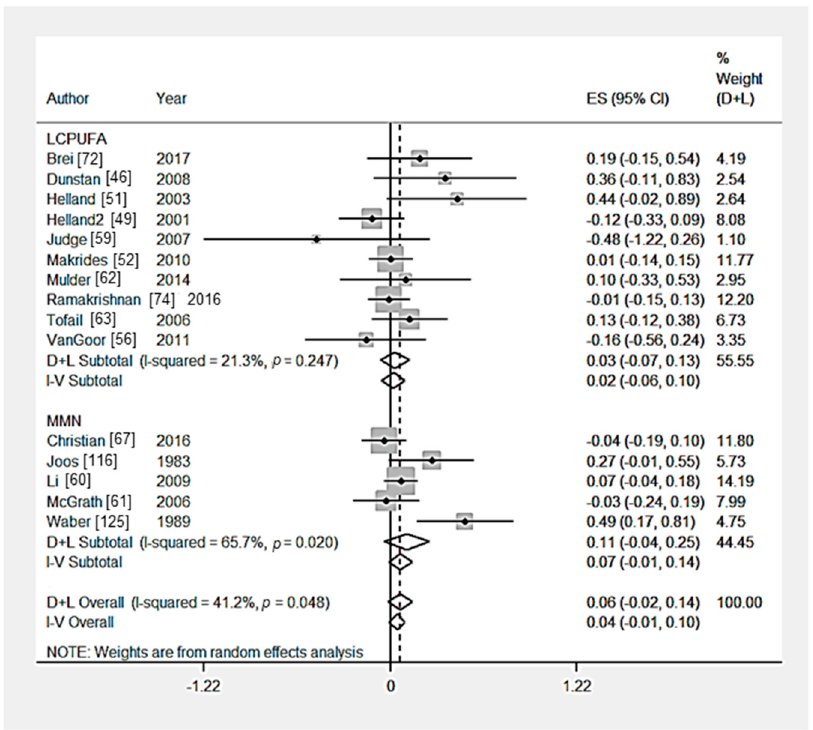
Figure 5. Forest plot for child global cognition outcomes. The overall effect size was estimated by standardised mean difference (SMD). LCPUFA, long chain polyunsaturated fatty acids; MMN, multiple micronutrient. D+L, random-effects estimate (Der Simonian and Laird method) and I-V, fixed-effects estimate (inverse variance method).